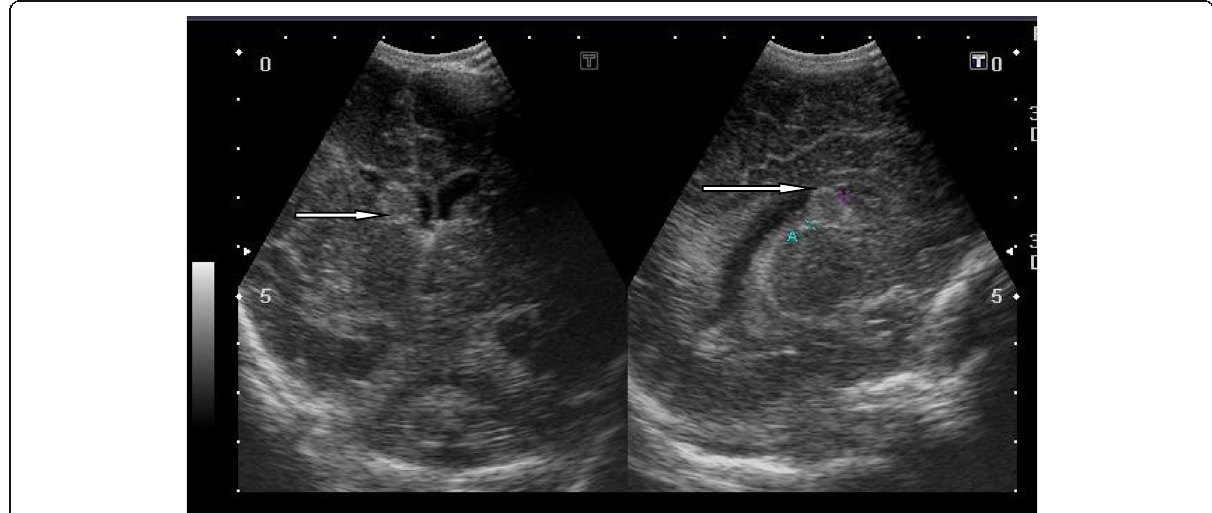
Fig. 8 Coronal and sagittal US of a neonate with Sarnat stage II showing large echogenic subependymal hemorrhage of the right lateral ventricle, extending into the lumen representing grade I periventricular hemorrgae with impending intra ventricular extension